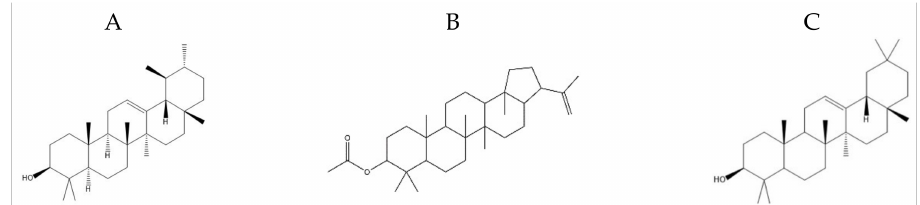
Figure 2. ( A – C ). Chemical structures of ( A ) α -amyrin, ( B ) A’-Neogammacer-22(29)-en-3-ol, acetate, (3.beta.,21.beta.)-, and ( C ) β